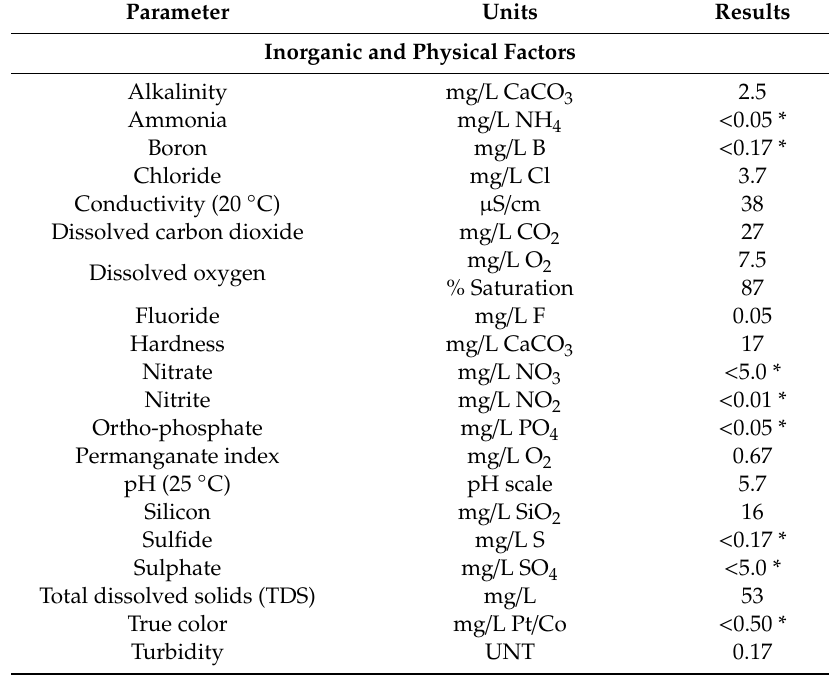
Table 2. Physicochemical analysis of Monfortinho thermal water: inorganic and physical parameters (n = 3).